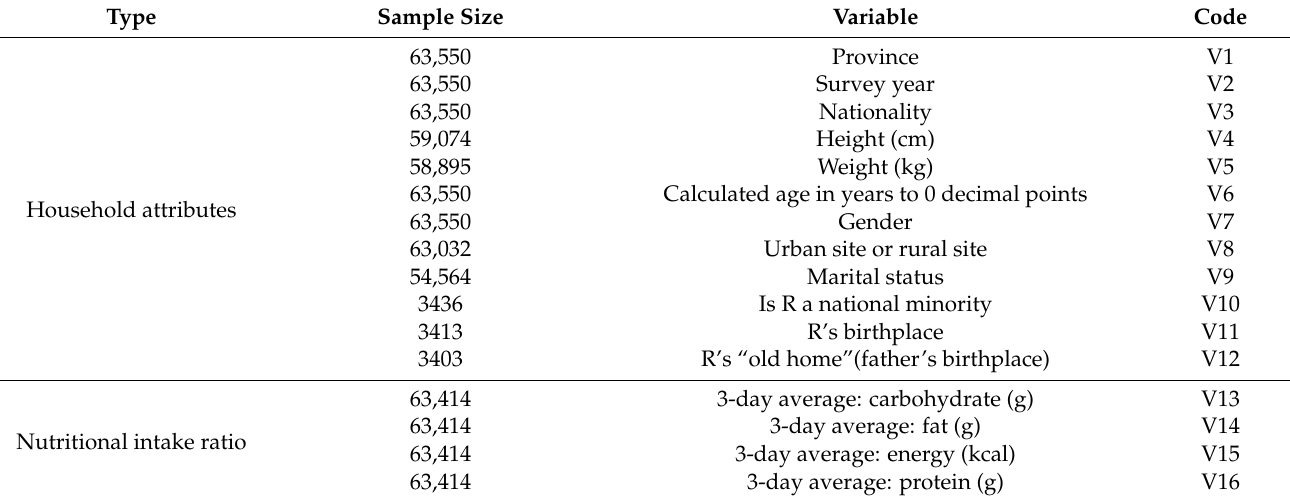
Table 2. List of independent